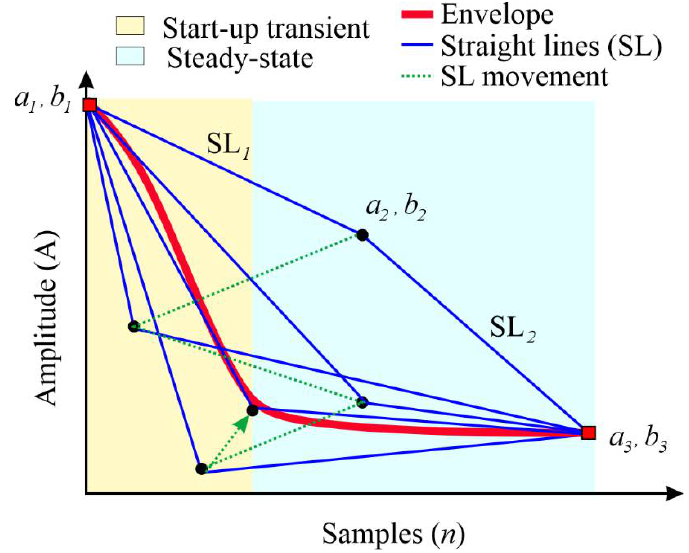
Figure 2. PSO-based strategy for regime separation.